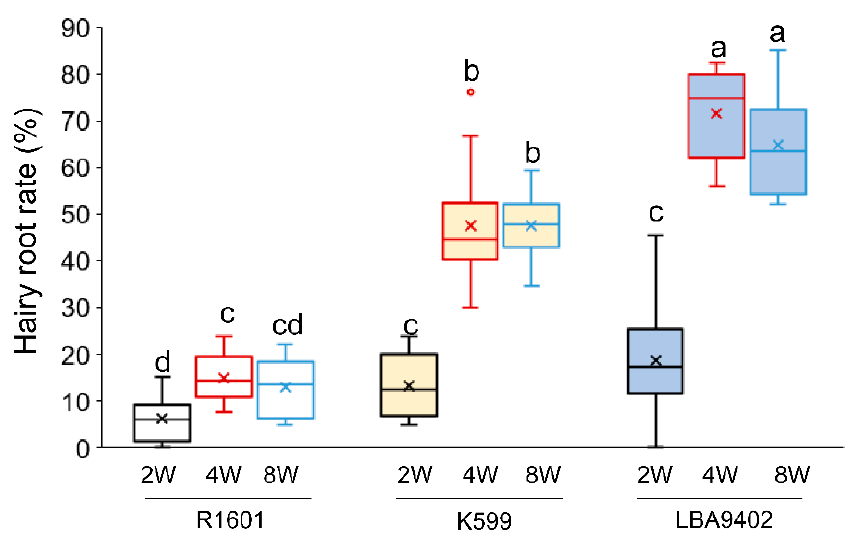
Figure 2. Effects of explant age and R. rhizogenes strain on hairy root generation efficiency. The data were statistically analyzed using one-way ANOVA. The data are presented as the mean ± standard error (SE) ( n = 3). Different letters indicate a statistically significant difference according to Duncan’s multiple range test ( p < 0.05).